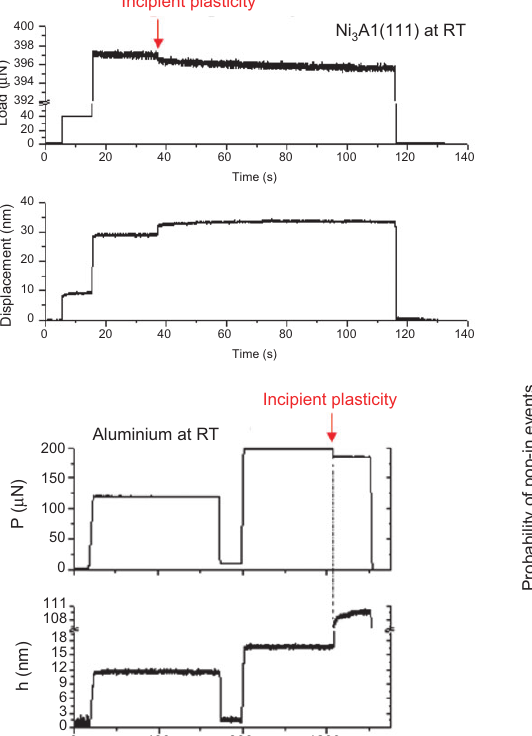
Al crystals. Data from ref. [16] . 3